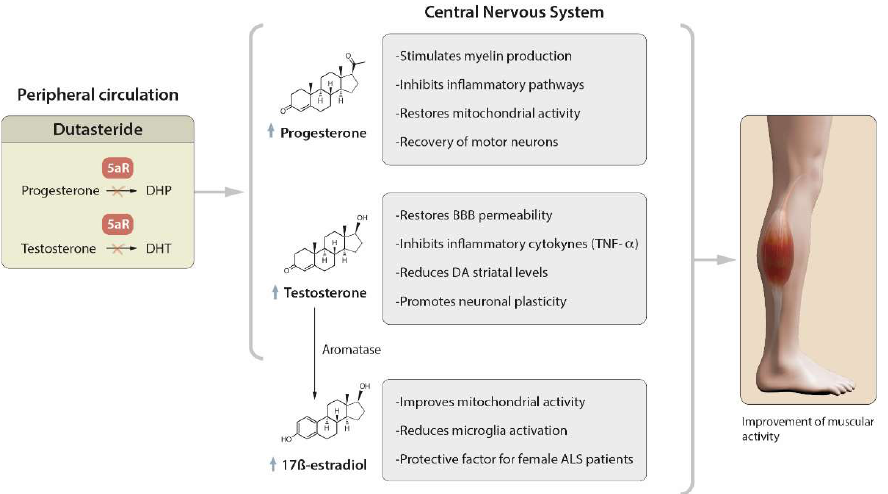
Figure 1. Therapeutic action of dutasteride through steroid hormones. In peripheral circulation, the inhibitory effect of 5AR by dutasteride will reduce the dihydroprogesterone (DHP) and dihydrotestosterone (DHT) levels, with the consequent possible increase (in the progesterone (PROG) and testosterone (T) levels. Both PROG and T will be more available to cross the blood–brain barrier and exert their therapeutic actions in the central nervous system. Moreover, T is substrate for the synthesis of 17 β -estradiol (17BE), which also possesses a neuroprotective role. In sum, these properties should restore the muscular activity in ALS patients. ↑ : increase of PROG, T or 17BE blood